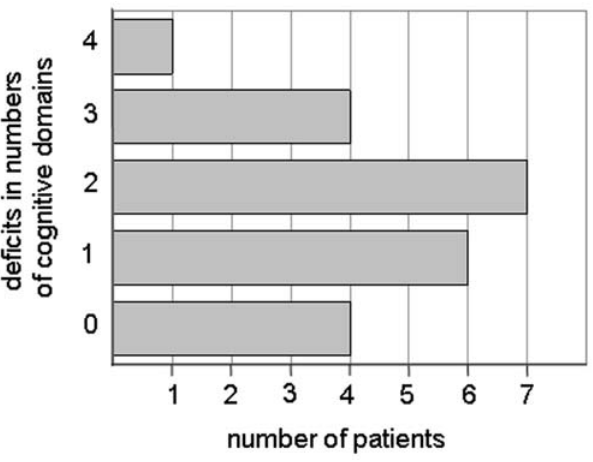
Table 1. Neuropsychological data as assessed prior and six weeks after PTA.